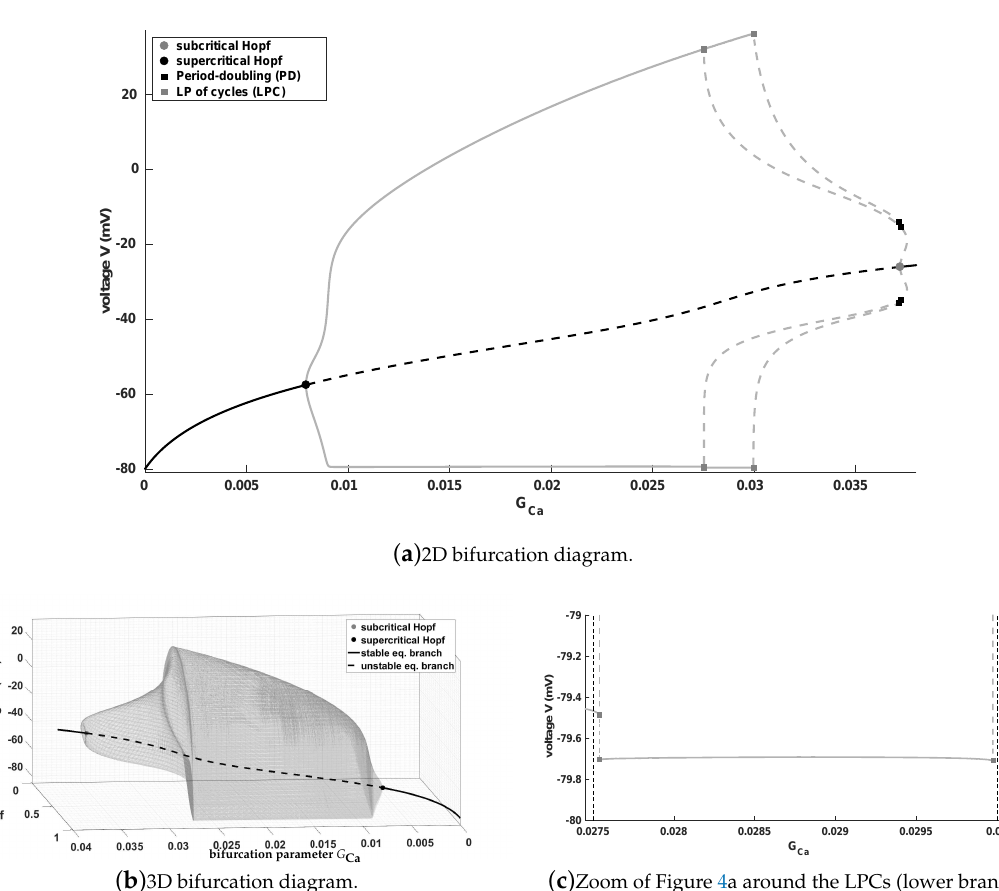
( c ) Zoom of Figure 4a around the LPCs (lower branch). Figure 4. Bifurcation diagram of system (1) with G Ca as bifurcation parameter. The black line denotes the stable branch of the equilibrium curve, while the black dashed line the unstable one. The grey line and grey dashed line represent the stable or unstable limit cycle branches,